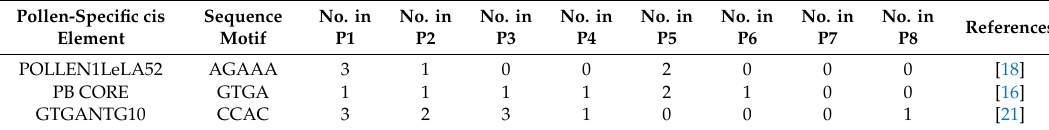
Table 2. Pollen-specific motif analysis of the pOsSUT3